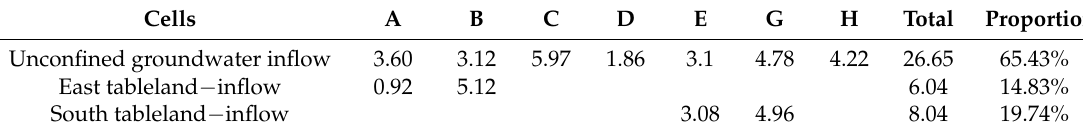
Table 4. Quantity of recharge from external systems received by the confined aquifer (10 6 m 3 /a). Cells